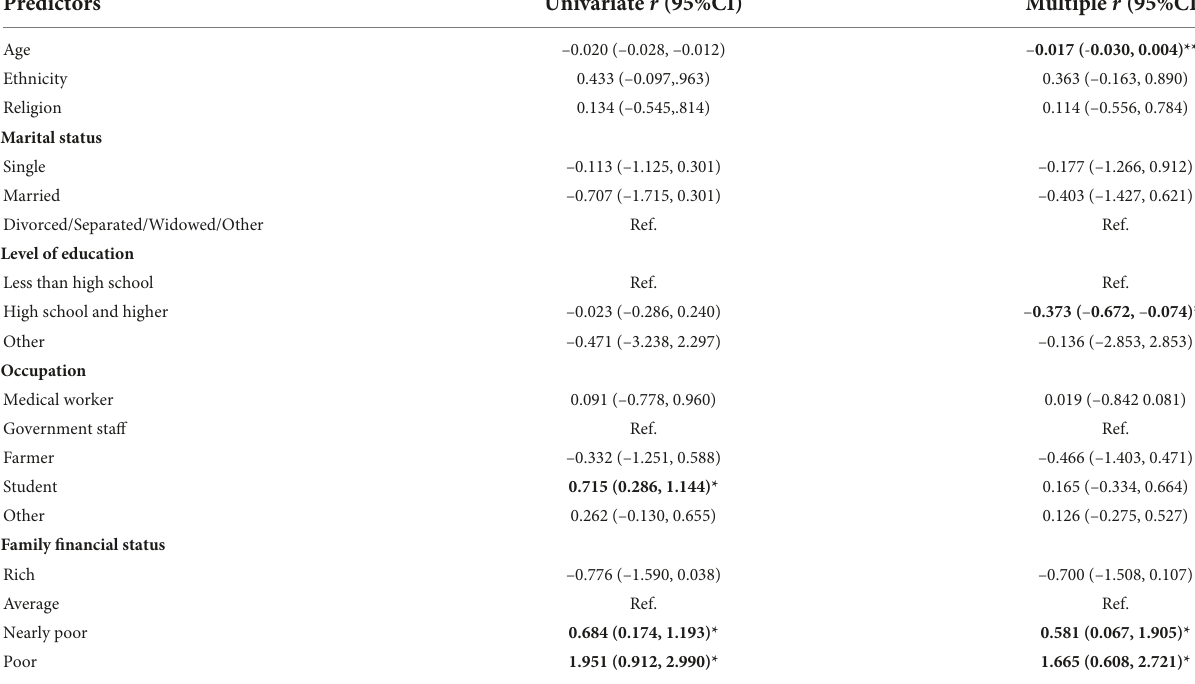
TABLE 3 Multiple linear regression model for the prediction of depression.